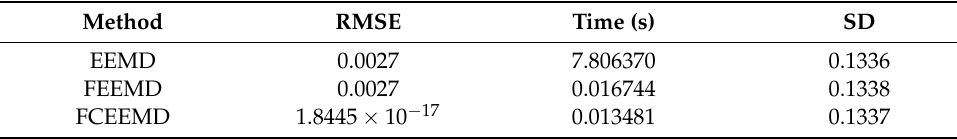
Figure 22. Comparative analysis of feature extraction methods based on different decomposition methods. ( a ) Reconstruction errors of different decomposition methods. ( b ) Envelope spectrums obtained by different decomposition methods. Table 5. The performance indexes of decomposition methods.